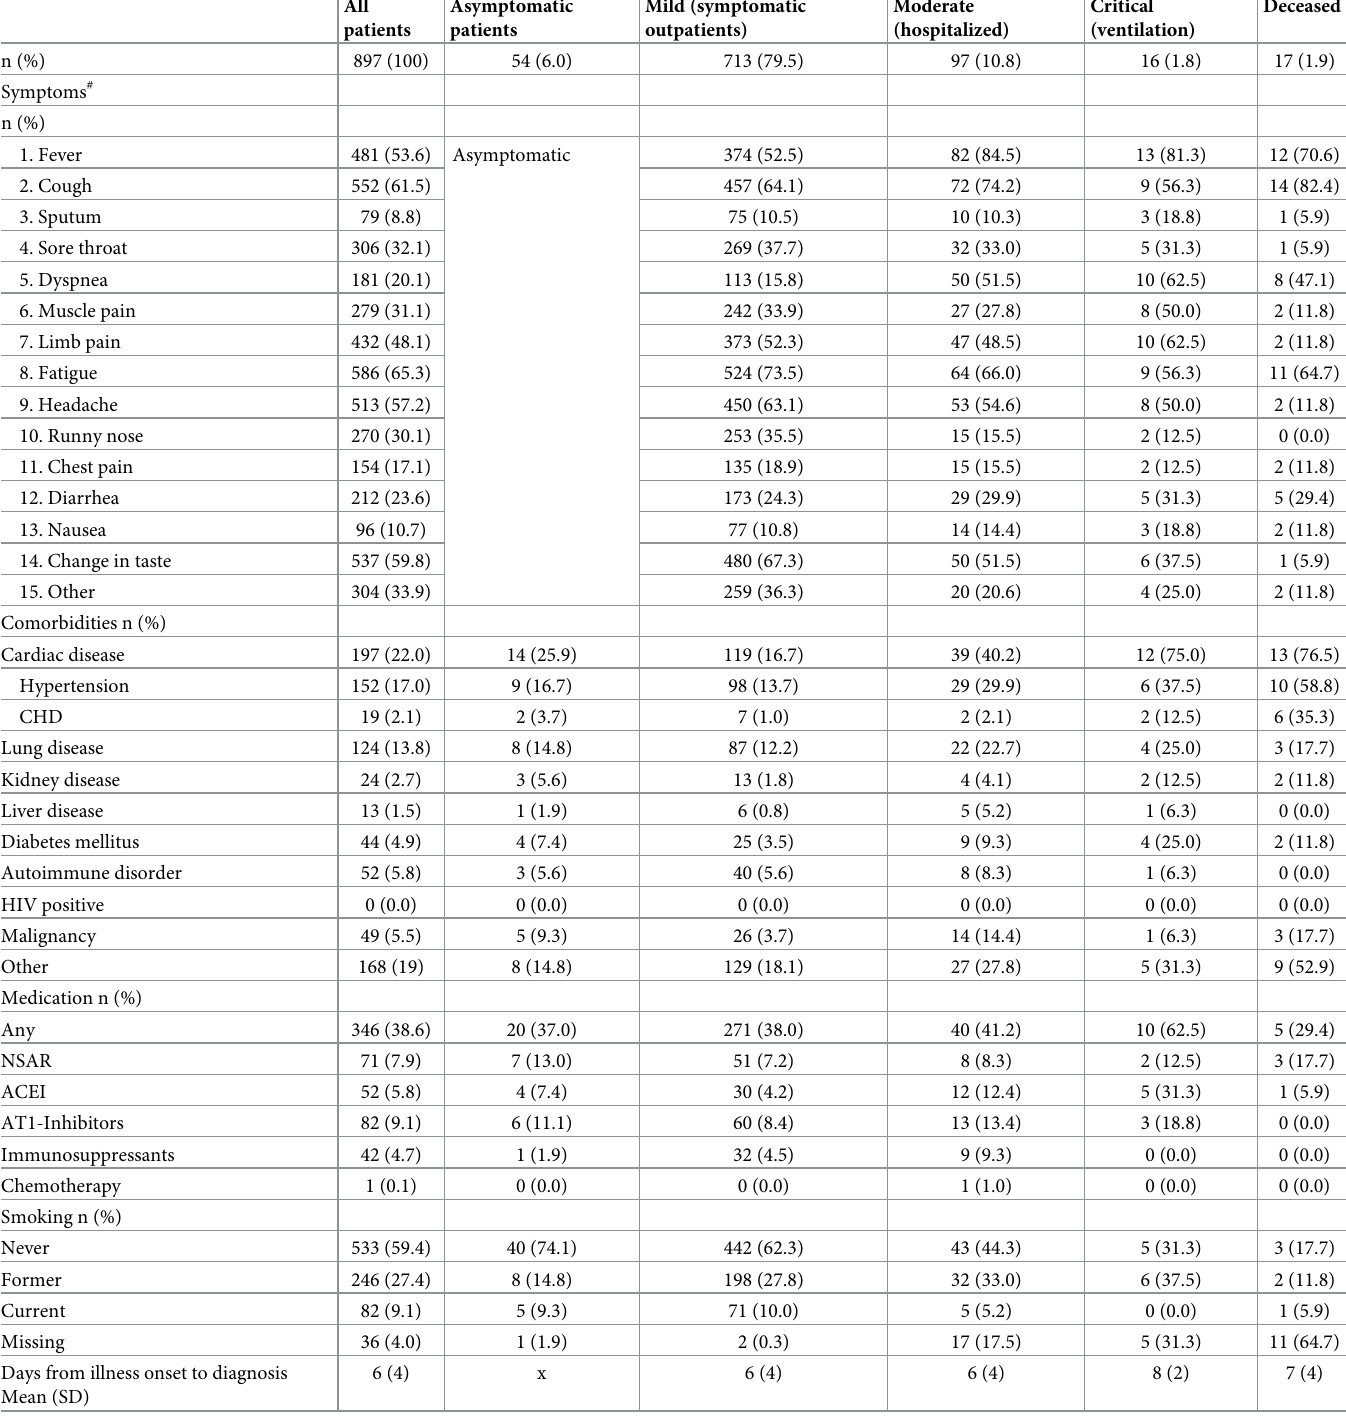
Table 2. Clinical course of